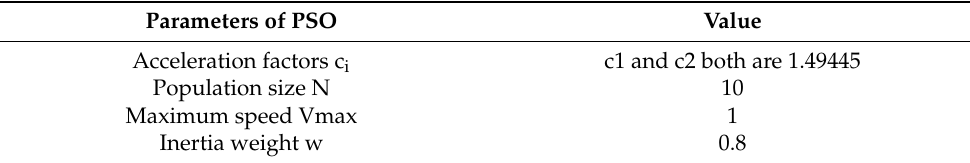
Table 7. Parameter